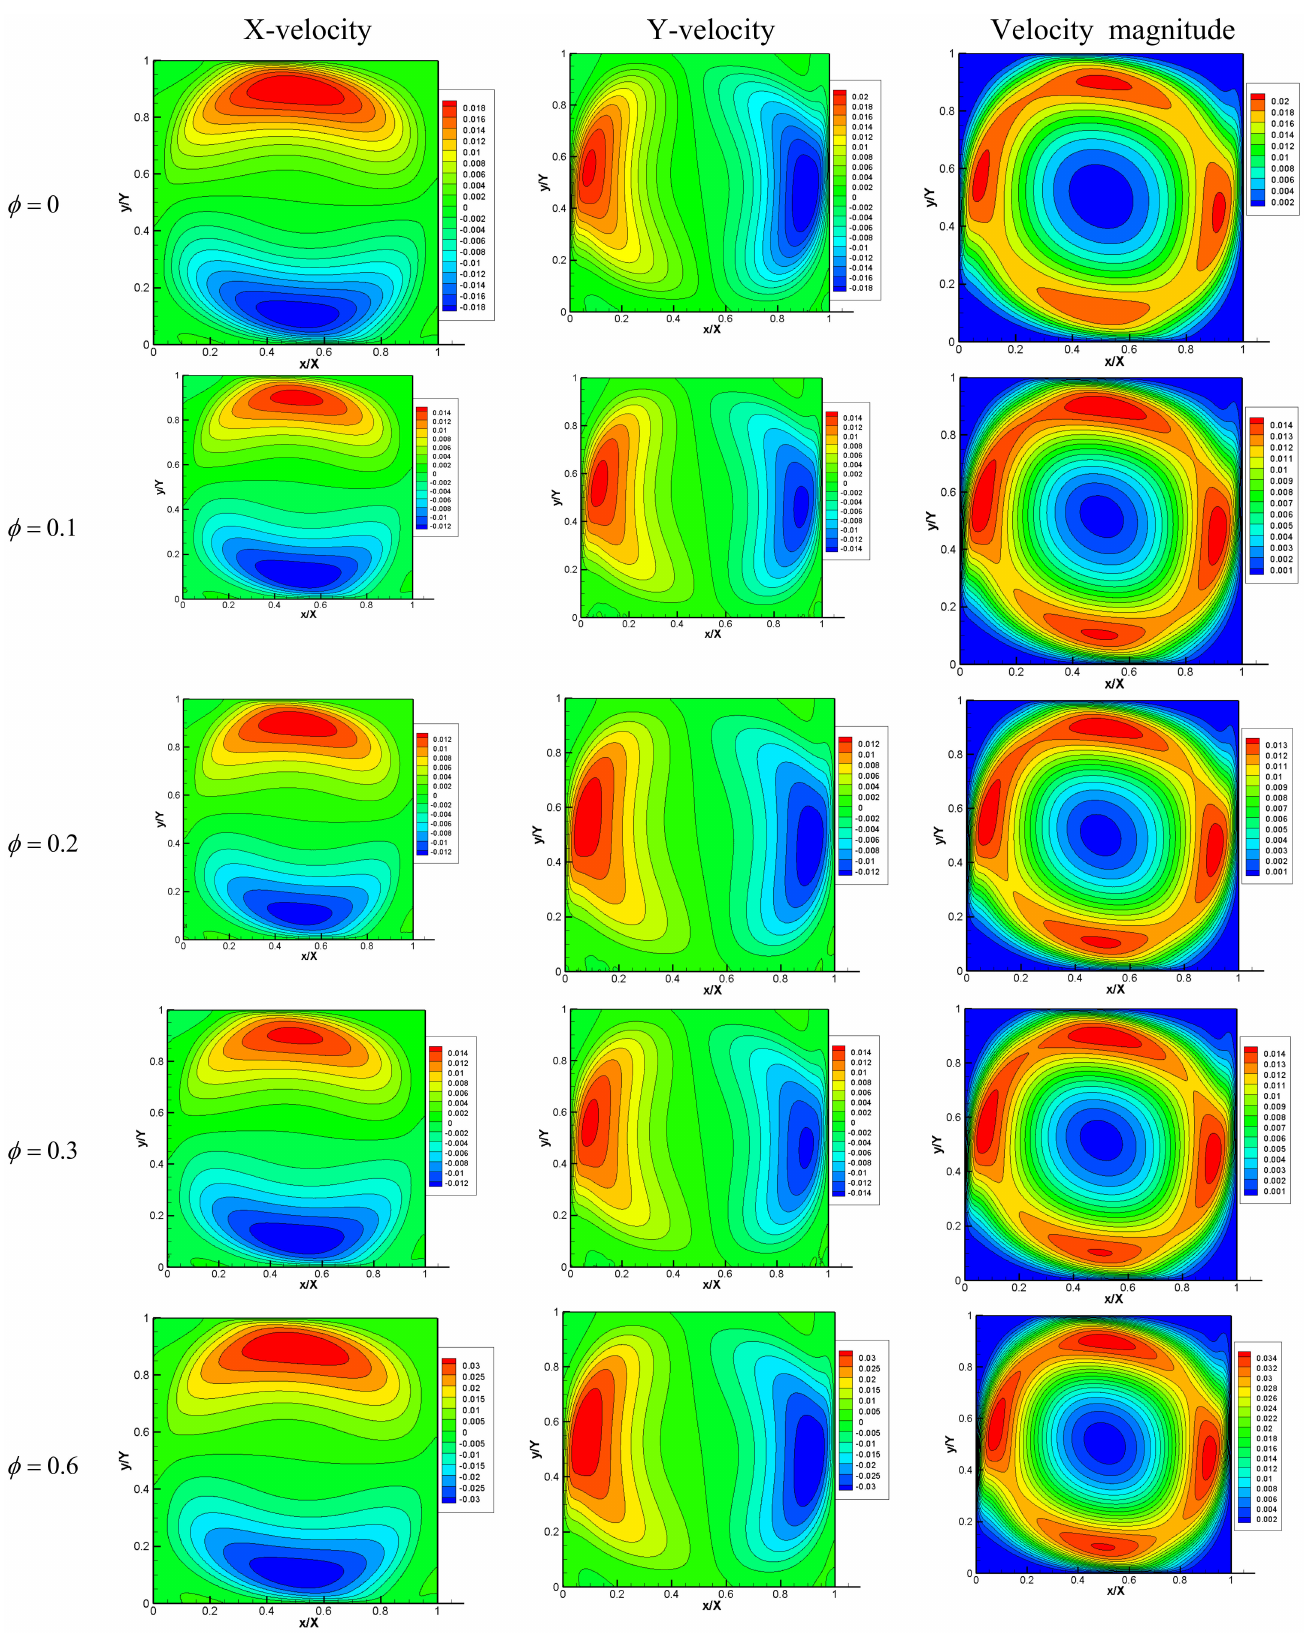
Figure 13. Steady state non-dimensional X-velocity, Y-velocity, and velocity magnitude profiles behavior for central partially left boundary conditions (case 2: linear boundary condition) at different volume fractions ( φ ) for Ra = 10 5